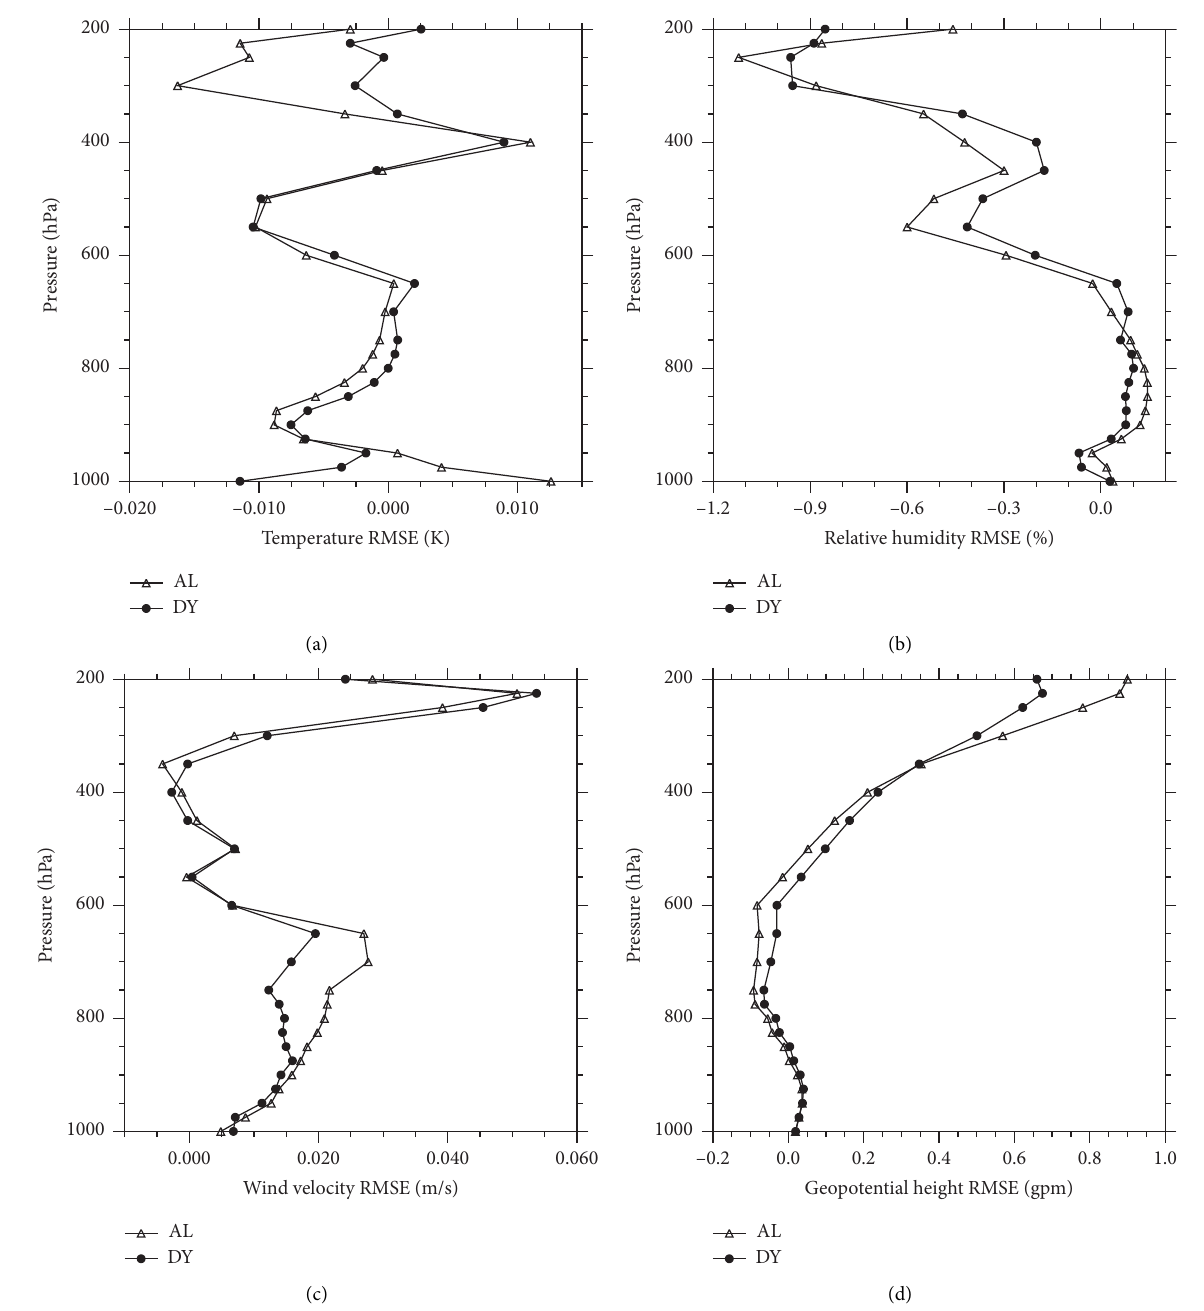
Figure 5: The vertical profiles of the averaged RMSEs differences between the analysis departures (O-A) and the first-guess departures (O-B) of the temperature (a) (unit: K), relative humidity (b) (unit: %), wind velocity (c) (unit: m/s), and geopotential height (d) (unit: gpm) from the AL (triangle line) and DY (circle line) experiments at 0000 UTC 23 June